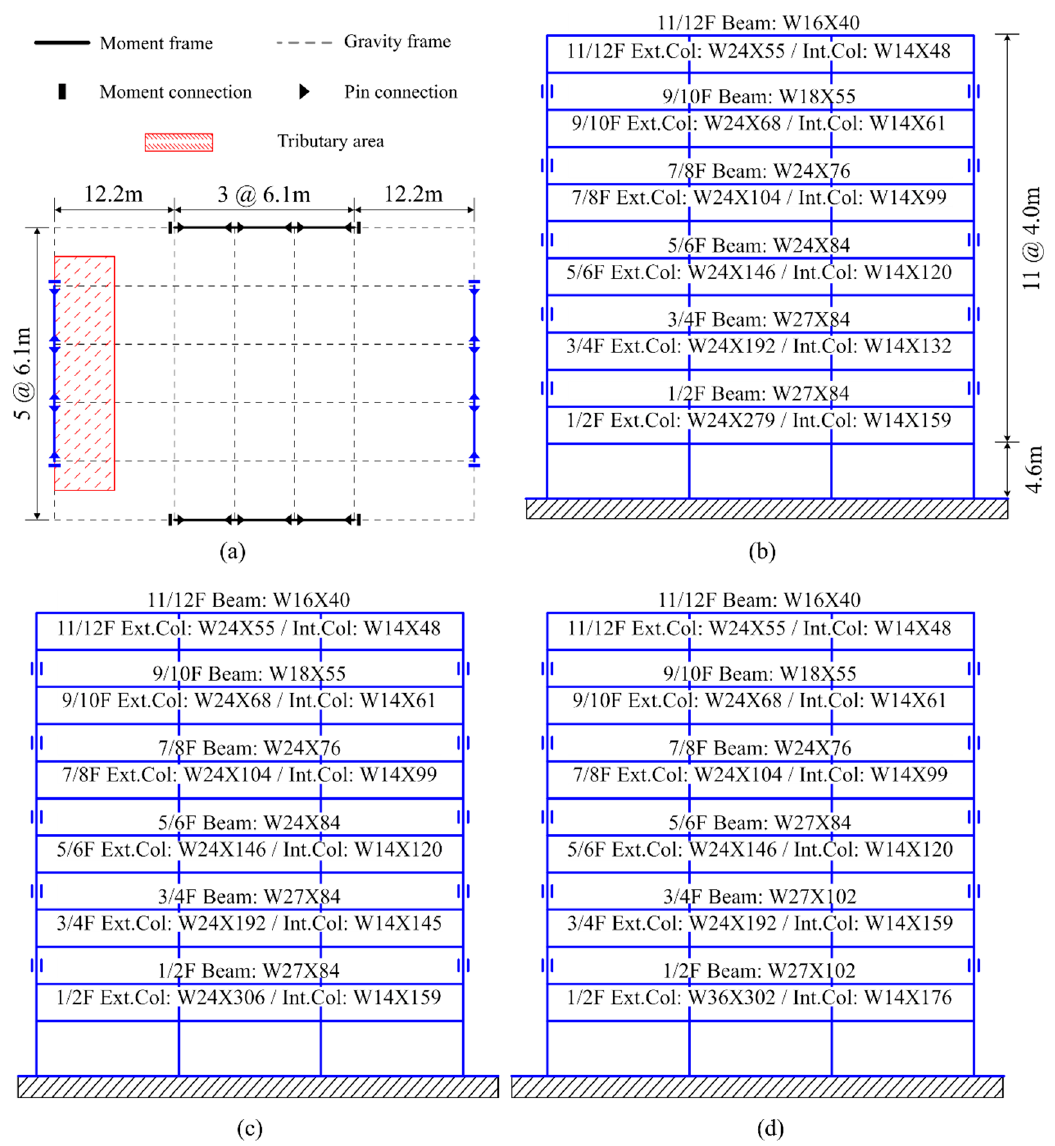
Figure 2. Plan and elevation of 15-story steel OMFs: ( a ) plan view; ( b ) elevation of 15-story W0-OMF; ( c ) elevation of 15-story W44-OMF; ( d ) elevation of 15-story